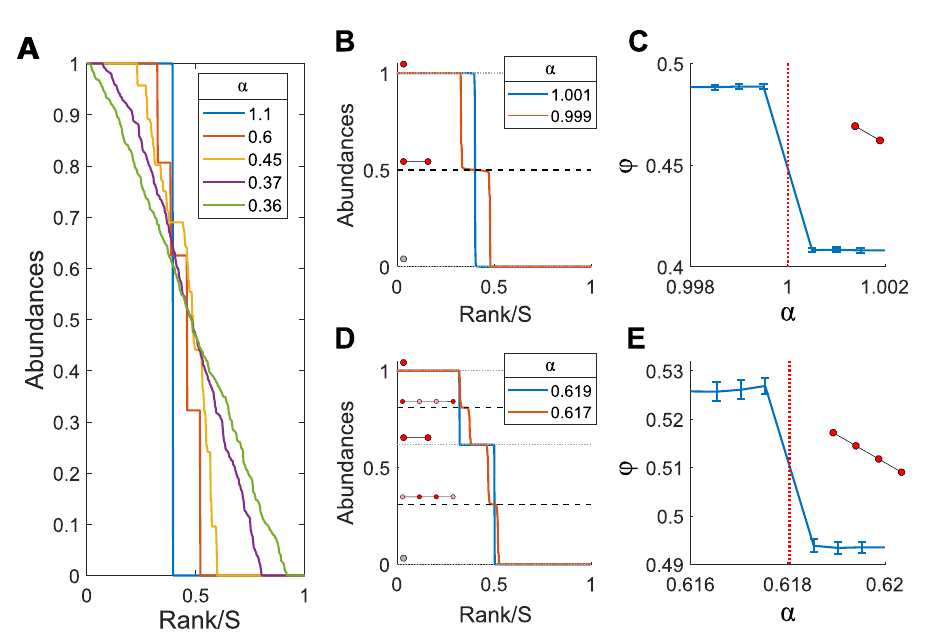
Fig 2. Changes in feasible and stable trees are reflected in species abundances. At each value of the interaction strength α , certain trees are allowed, and the abundance of a species depends only on α and the position within a tree. (A) The rank-abundance curves at equilibria reached dynamically for S = 400, C = 3, at several values of α . As α decreases, the increasing number of feasible and stable trees generates more possible species abundances. (B-E) Relative diversity and species abundances on both sides of two transitions at a ð n Þ for n = 2, 4, where new trees appear. chain (C) and (E) show the behavior of ϕ around the transitions associated with pairs of species and chains of length 4 respectively becoming feasible and stable. (B) and (D) show the abundances at equilibria at values of α on two sides of the transitions. The expected abundances are marked by dashed black lines, with thicker lines for the abundances of the species in the tree associated with the transition. Next to each abundance appears the tree that contains it, with the species that have this abundance in dark red (or gray in the case of the abundance 0 of extinct